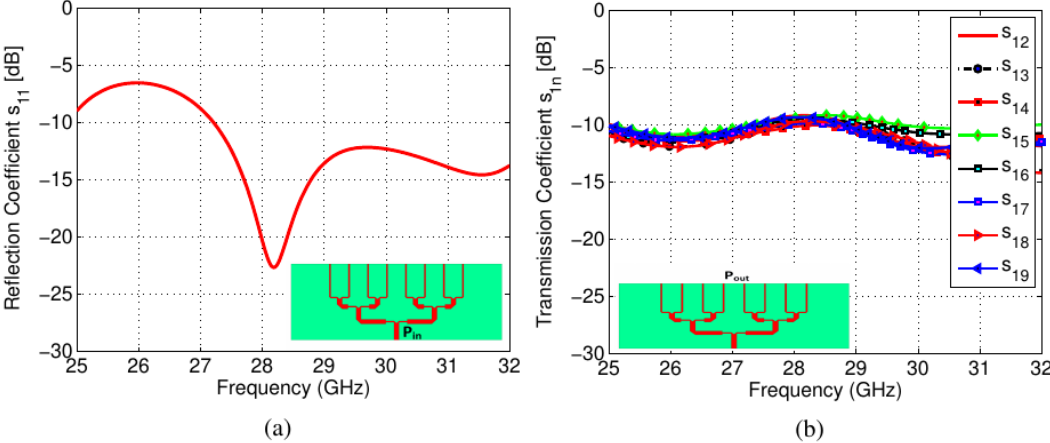
Figure 6. Scattering parameters of PD: ( a ) S 11 , ( b ) S 1n .